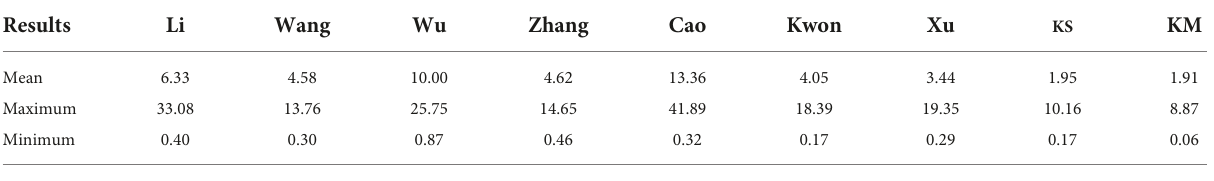
TABLE 2 Real spectral recovery results of the proposed and other existing methods.